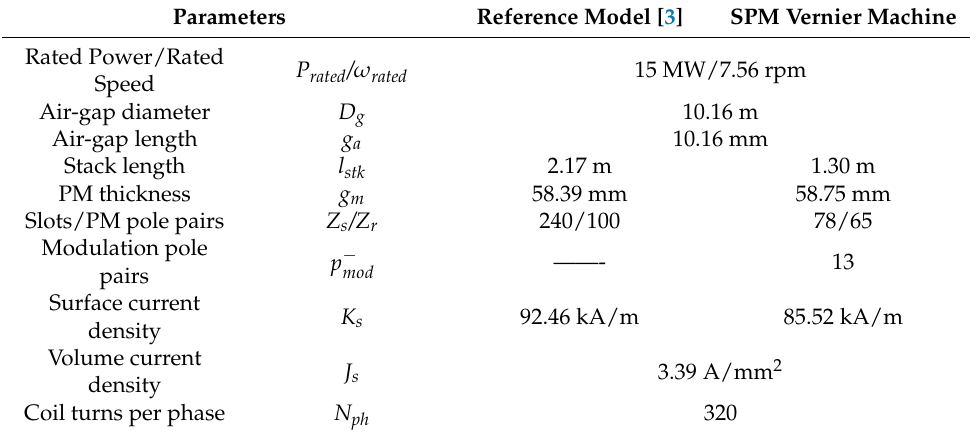
Table 1. Design Parameters.